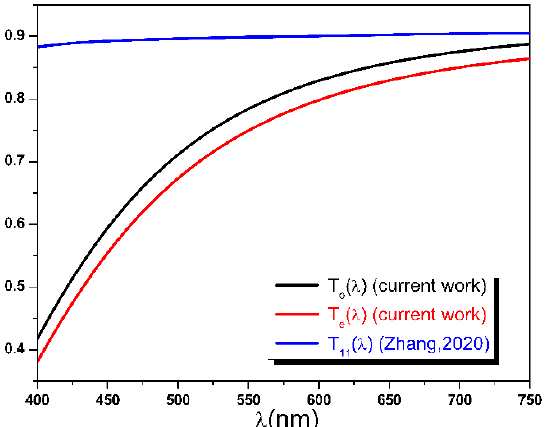
Figure 15. Calculated transmittance using n ( λ ) and κ ( λ ) of reference [11] compared with fitted T o ( λ ) and T e ( λ ) of the current